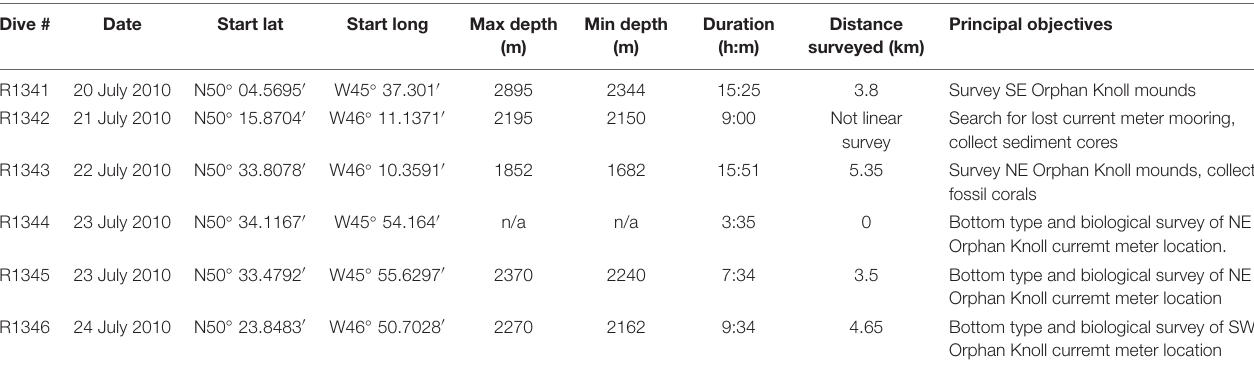
Bottom type and biological survey of SW Orphan Knoll curremt meter